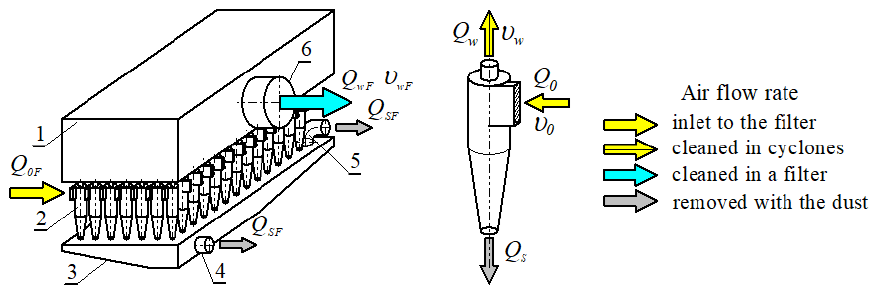
Figure 22. Tracked vehicle air filter: 1—porous baffle, 2—cyclone D -40 multicyclone, 3—dust trap, 4/5—right/left) suction port and 6—cleaned air port.